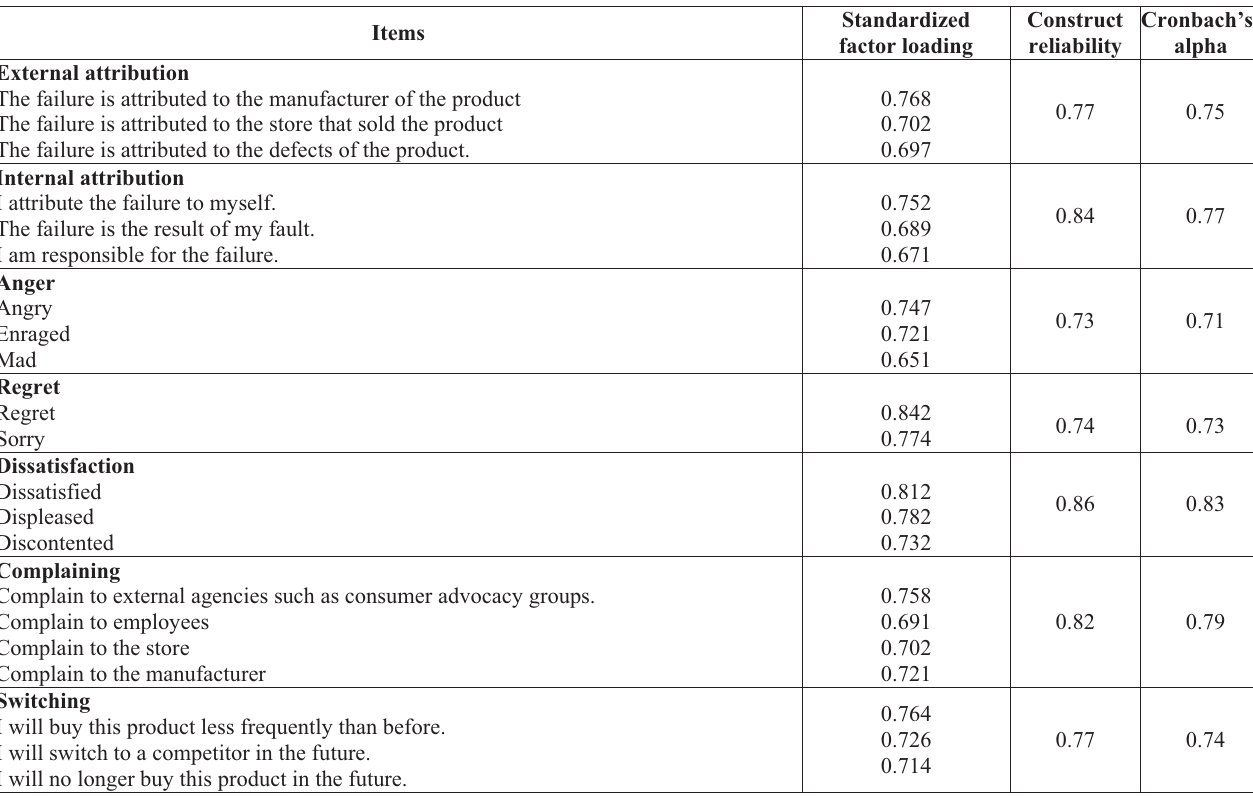
Table 1: Measurement items, standardized factor loadings, construct reliability and Cronbach's Alpha